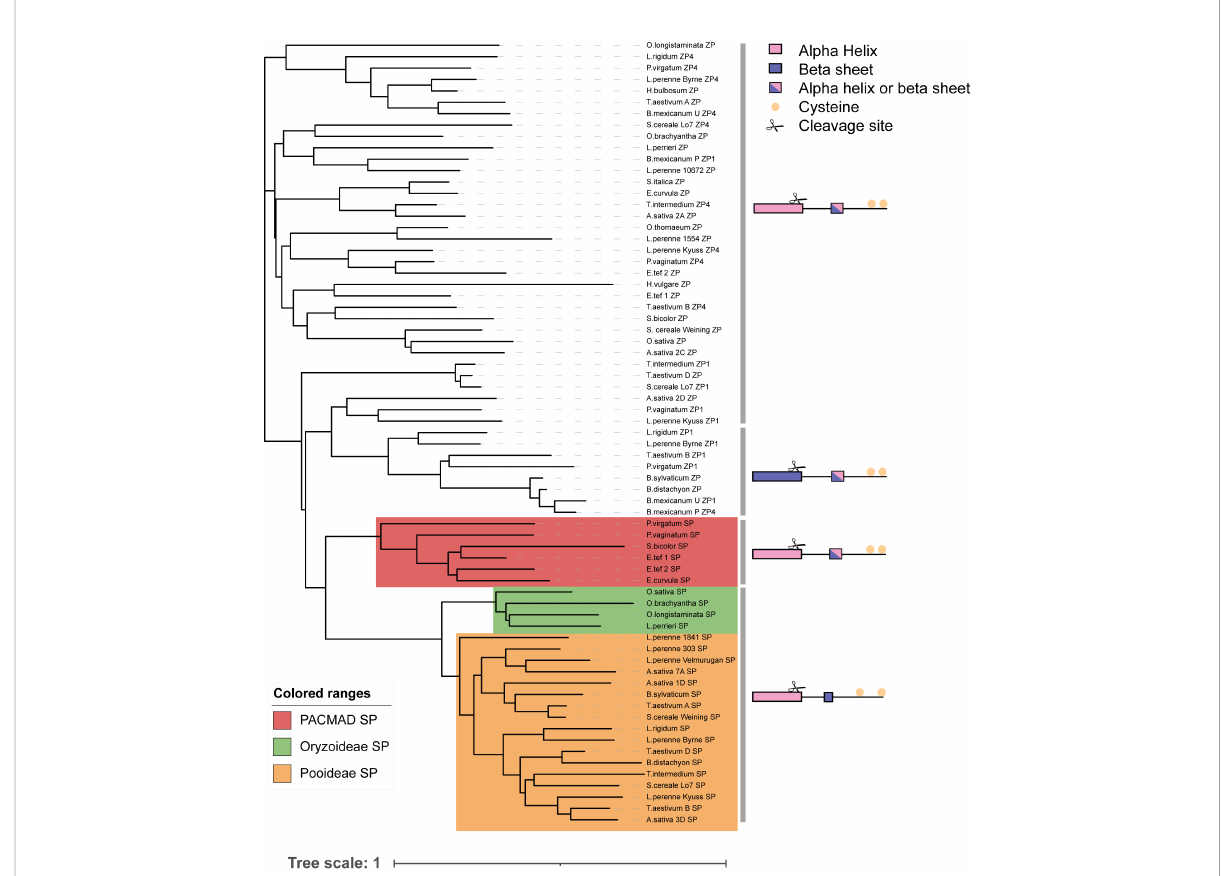
FIGURE 7 Phylogeny of SP/ZP genes from various grass species. A phylogenetic tree constructed using the sequences of all SP/ZP protein sequences. To produce the tree a global alignment with a BLOSUM45 cost matrix was performed, followed by tree building using a Jukes Cantor genetic distance model and nearest neighbor tree-building method. Representative structures, cleavage and cysteine location of each sub-clade shown at right. Scale bar indicates substitutions per